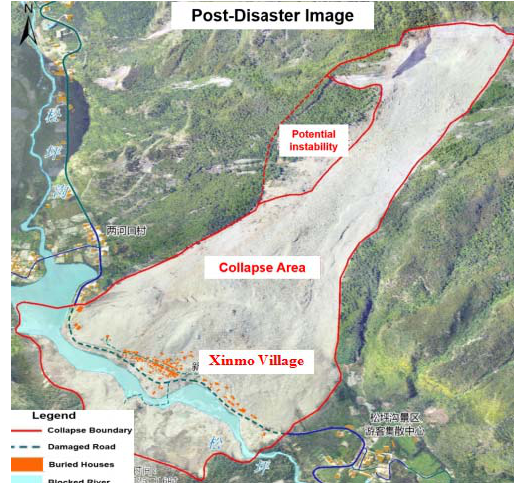
Figure 10. Post-Disaster Image of Xinmo Village (Technology Innovation Center of Emergency Surveying and Mapping,